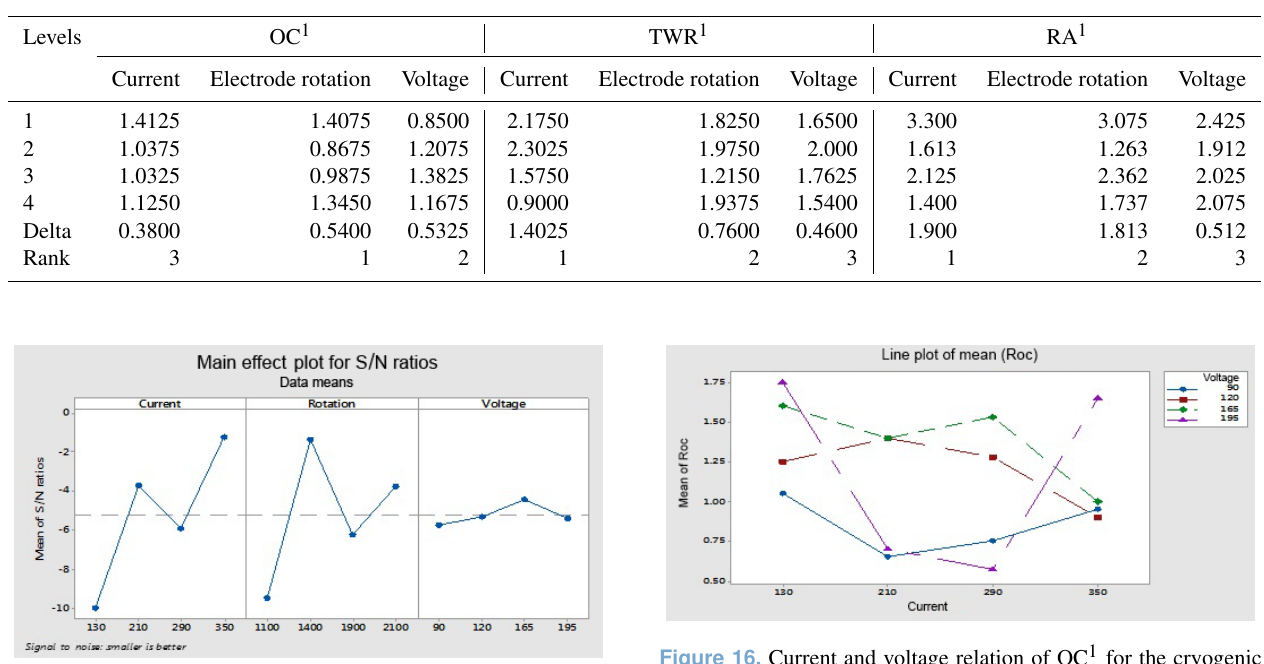
Table 9. Mean response table for the deep cryogenically treated with tempering (CTT) electrode.